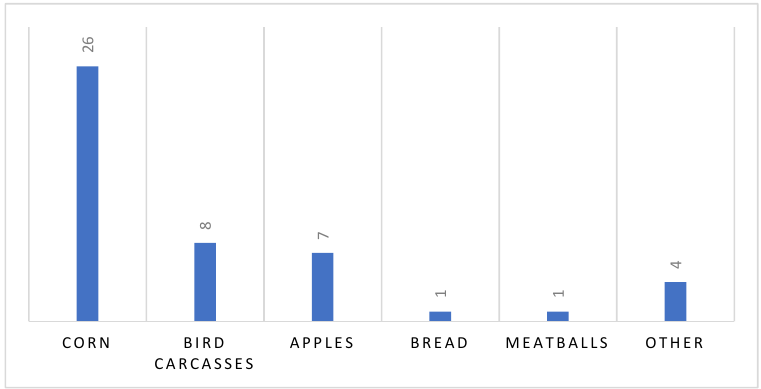
Figure 3. Type and number of positive matrices.